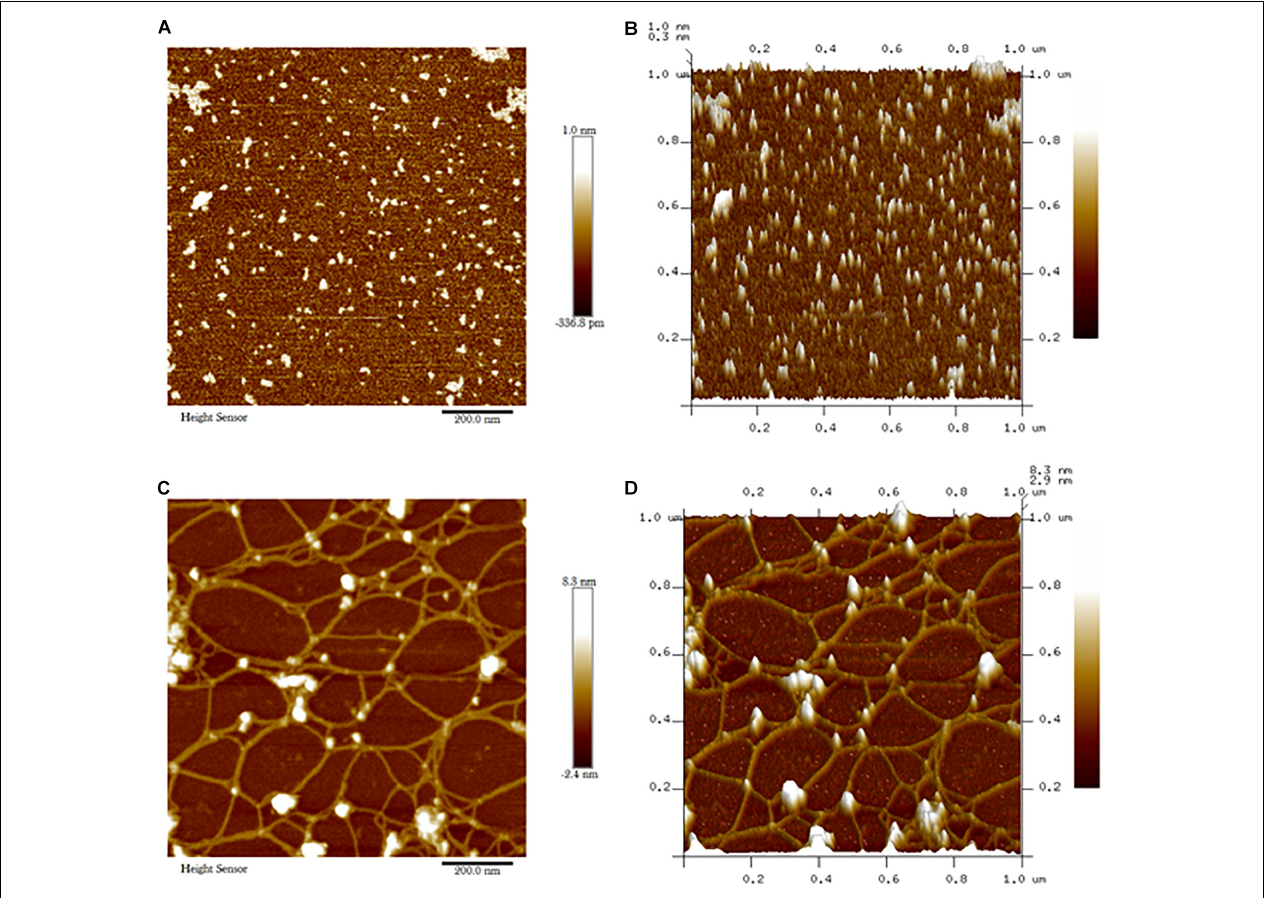
FIGURE 6 | Atomic force microscopy (AFM) of biochar particles and Cordyceps fumosorosea -Biochar nanoparticles. (A) 2D image of biochar particles. (B) 2D image of biochar particles. (C) 2D image of Cordyceps fumosorosea -biochar nanoparticles. (D) 3D image of Cordyceps fumosorosea-biochar